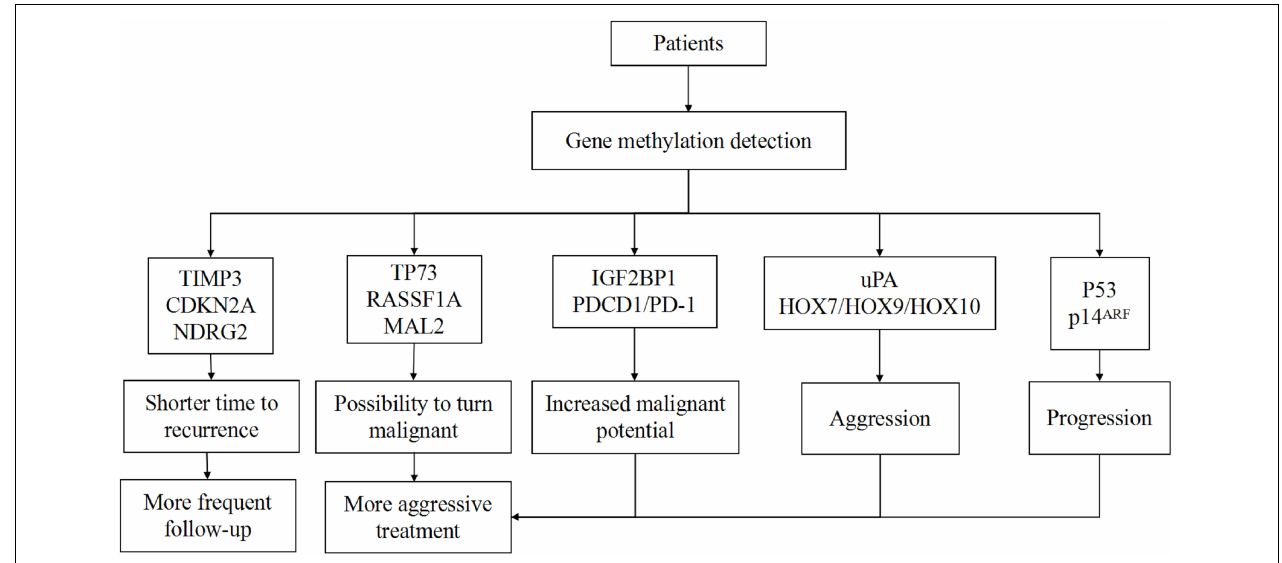
FIGURE 1 | Patient classification based on